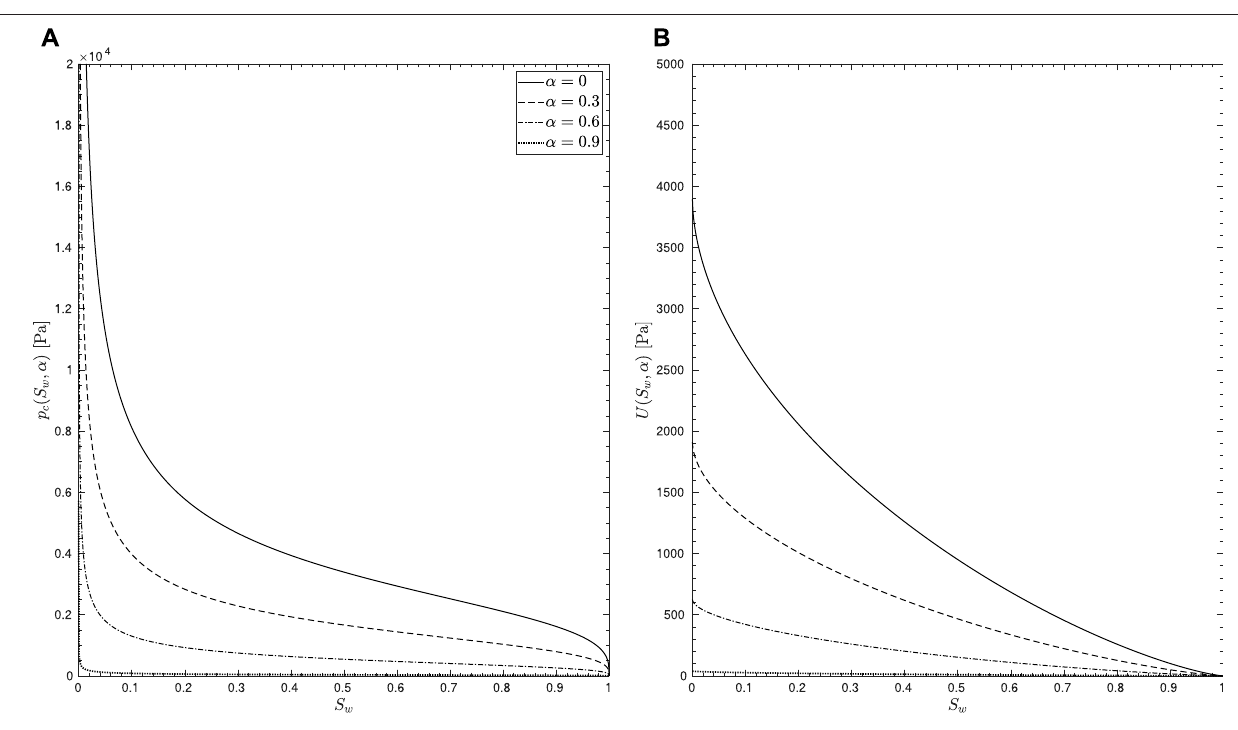
FIGURE 1 | Proposed degradation of the retention properties with evolution of damage depicted for material properties taken from Table 1 , (A) macroscopic capillary pressure, p c ( S w , α ), in Eq. 1 , (B) interfacial energy density, U ( S w , α ), in Eq. 7